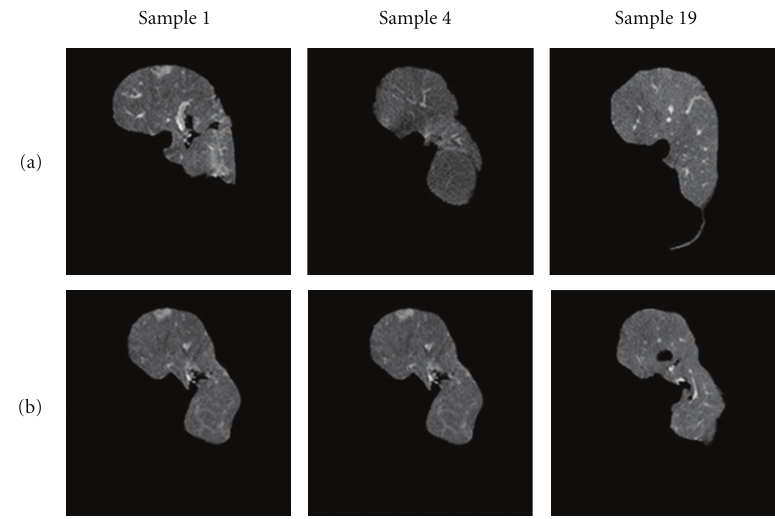
Figure 4: Example of datasets (some slices). (a) Original datasets. (b) 3D shape normalized datasets.